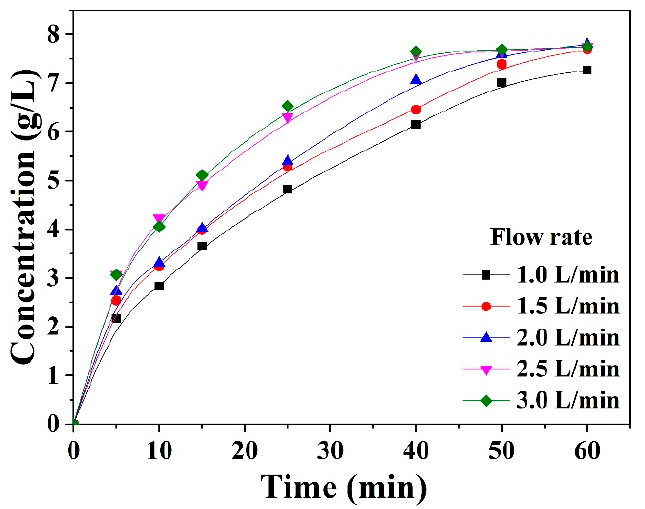
Figure 6. Effect of flow rate on carbonization reaction [liquid-solid ratio = 20, temperature = 25 °C].